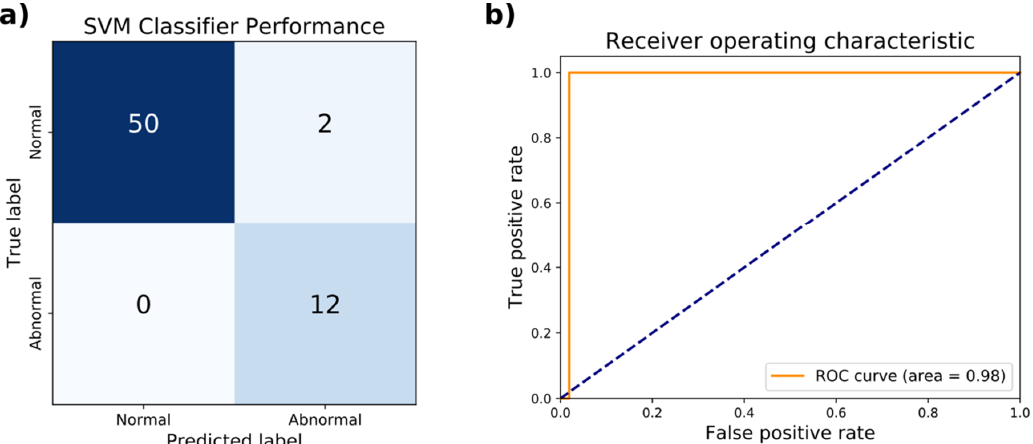
Figure 4. Test set performance of the support vector machine classifier on distinguishing normal from abnormal gaits. ( a ) The confusion matrix comparing the true classification of normal or abnormal gait against the predicted classification is shown. ( b ) The receiver operating characteristic (ROC) curve achieves an area under the curve (AUC) of 0.98.